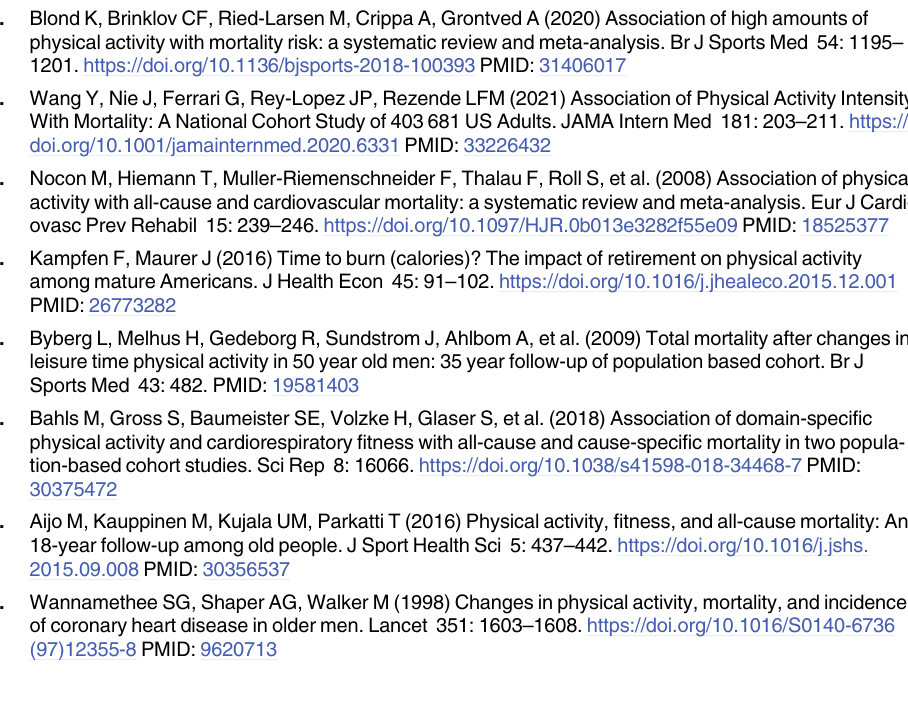
S3 Table. All-cause mortality risk of the groups according to activity category using Cox regression models censoring those who died in 2013. (DOCX) S1 Fig. Plotted scaled Schoenfeld residuals for Model 1 for group, age, and sex.